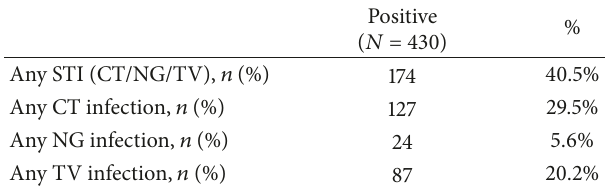
Table 2: Prevalence of Chlamydia trachomatis , Neisseria gonor- rhoeae , and Trichomonas vaginalis among HIV-infected pregnant women in the facilities in Tshwane District, South